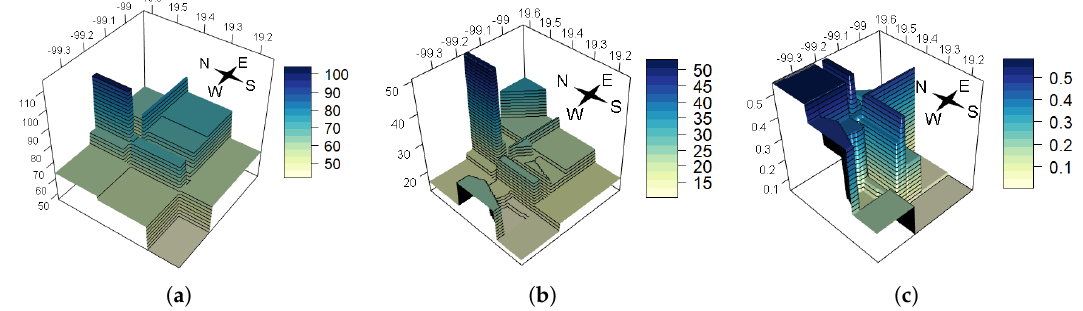
Figure 6. ( a ) Three-dimensional representation of the adjusted decision tree of the location parameter, ( b ) scale parameter, and ( c ) shape parameter. The X and Y axes are in geographical coordinates (decimal degrees). Z is the calculated value of the corresponding parameter (location, scale, and shape), for each geographical